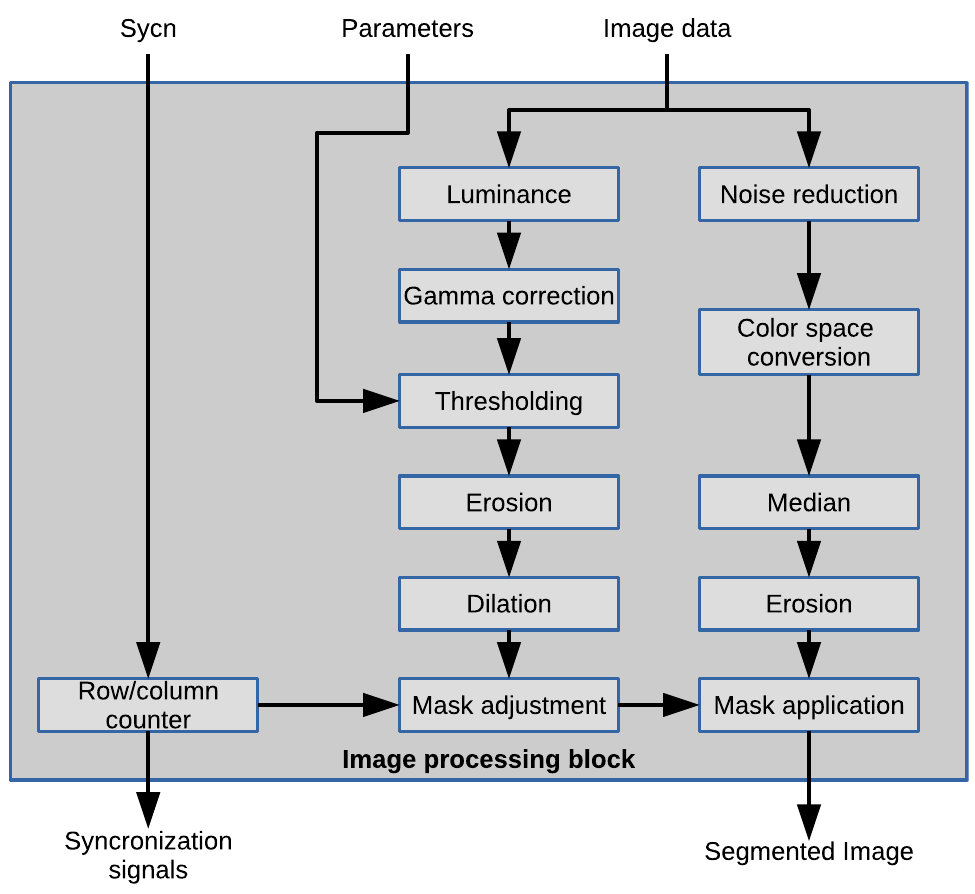
Figure 2. Block diagram of the image processing module.